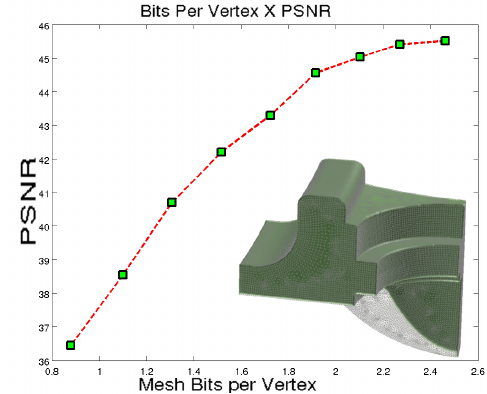
Figure 14: PSNR error depending on the compression rate (BPV) to the Fandisk model.